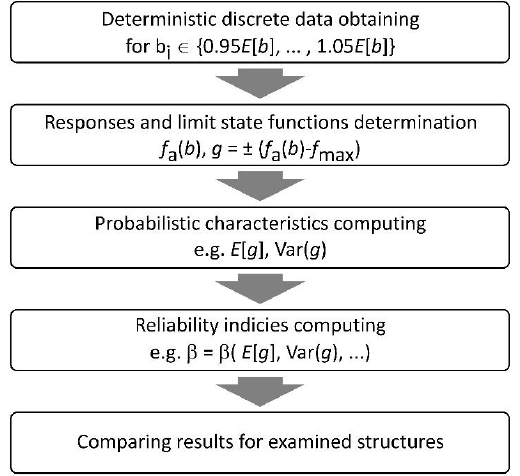
Figure 1. Exemplary structure reliability comparison scheme.